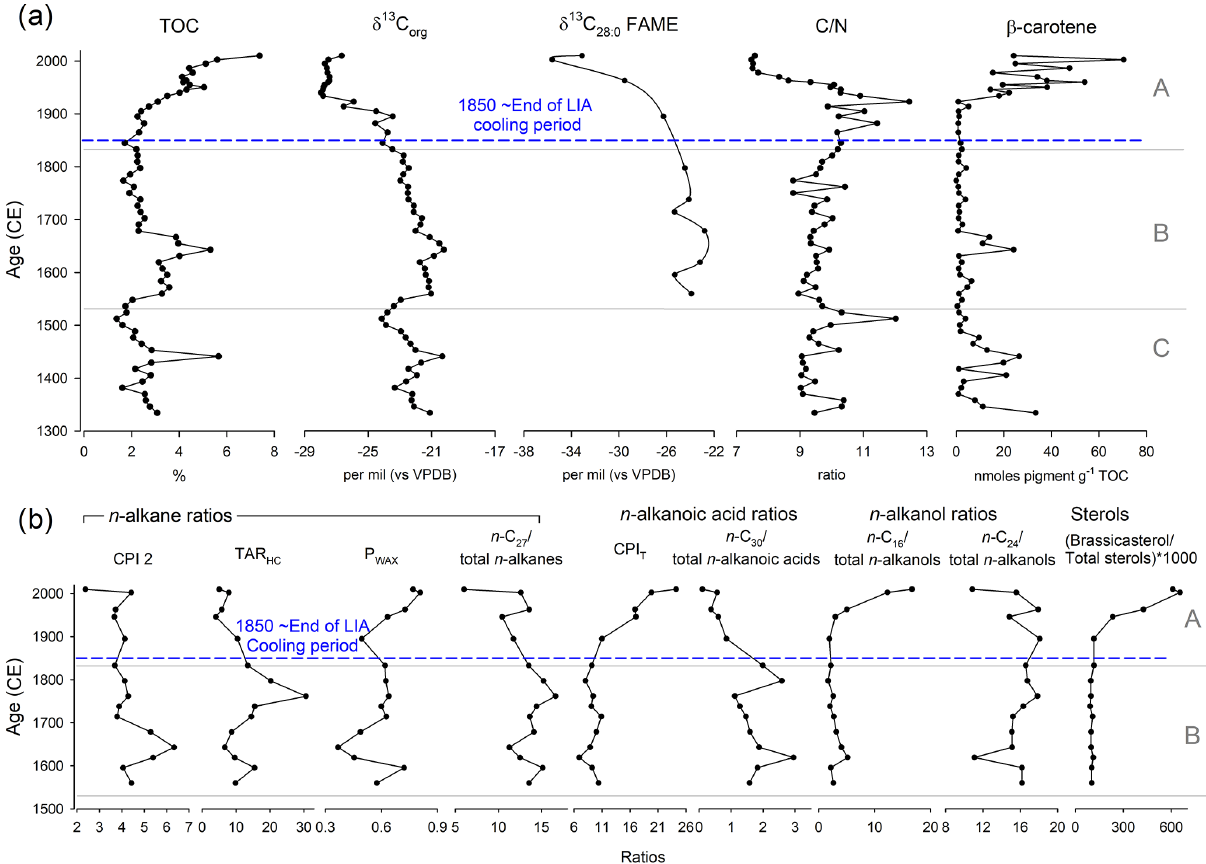
Figure 7. (a) Down-core bulk and compound-specific isotopic geochemical parameters from the Disko 2 (K1) short core, presented against modelled age (CE). (b) Down-core lipid geochemical ratios and equations including CPI 2, TAR HC , P WAX , n -C 27 /total n -alkanes, CPI T , n -C 30 / total n -alkanoic acids, n -C 16 / total n -alkanols, n -C 24 / total n -alkanols and (brassicasterol / total sterols) × 1000. For abbreviations